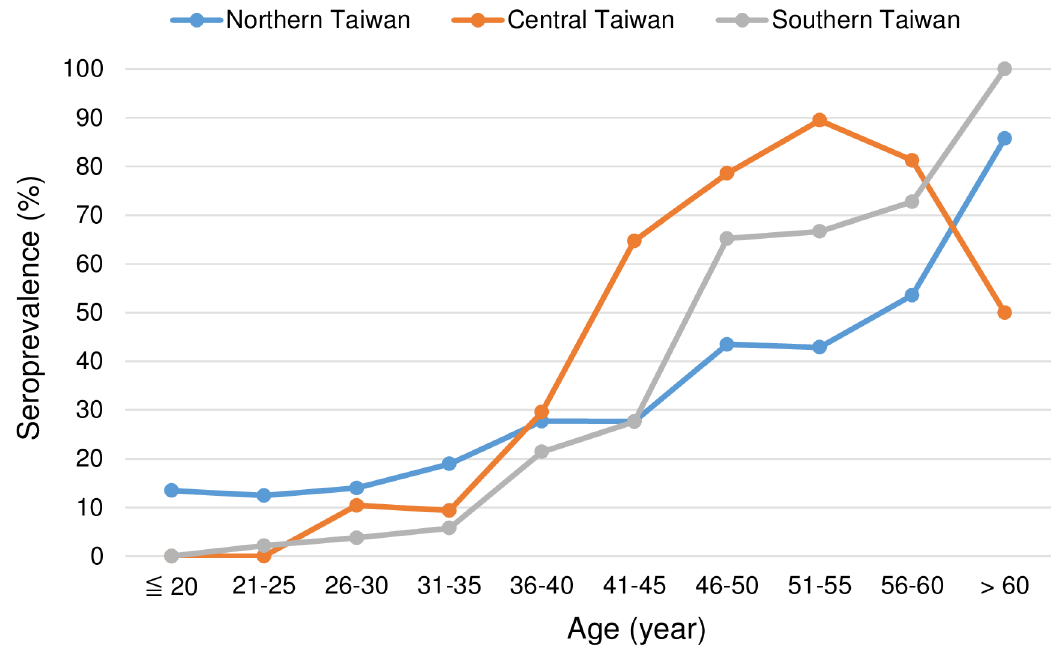
Fig 1. Comparisons of hepatitis A virus seroprevalence according to different regions in